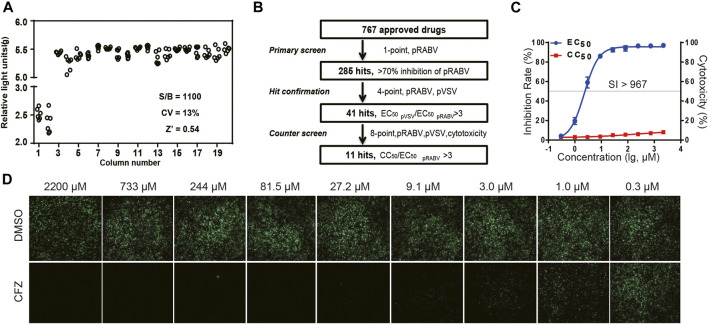
HTS for inhibitors of RABV from 767 compounds. (A) Scatter plot of results from DMSO plate screening. Wells in columns 1 and 2 of the 96-well assay plates contained 293Tcells as a control (0% response), whereas pseudotyped RABV (pRABV) was added to all other wells (positive control, 100% response). The signal-to-basal ratio (S/B) in this plate was 1100-fold, with a CV of 13% and Z′ factor of 0.54. (B) HTS assay flow chart using pRABV. (C). Inhibition rate of CFZin the RFFIT assay is shown in blue, and cytotoxicity of compounds on host cells is shown in red. (D).The RFFIT assay of CFZ.